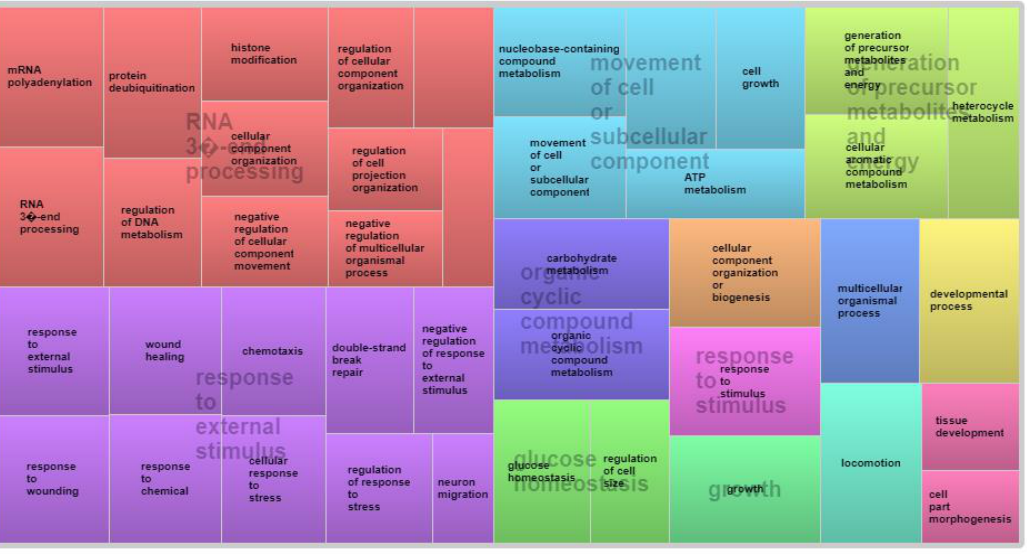
Figure 4. Analysis of biological processes co-associated with muscling evaluated based on visual scores in Nellore cattle.